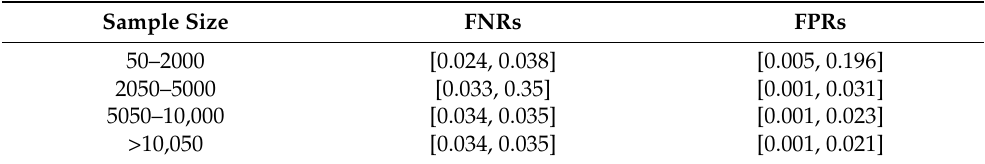
Table 7. The sample size ranges with minimum and maximum FNRs and FPRs of group 2 dataset combined with PAC parameters.